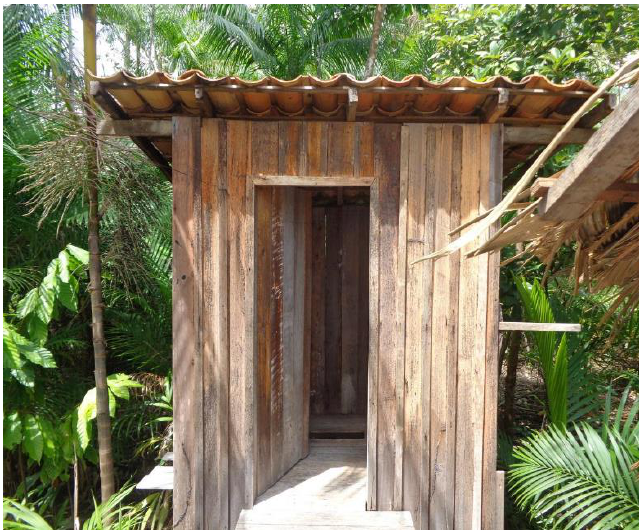
Figura 3: Tipo de banheiro utilizado pelos moradores do PAE Fonte: IATAM,